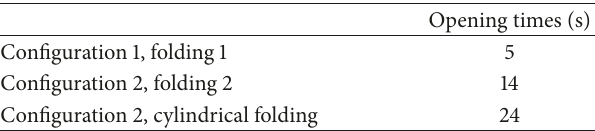
Table 2: Different opening times under different configuration and number of